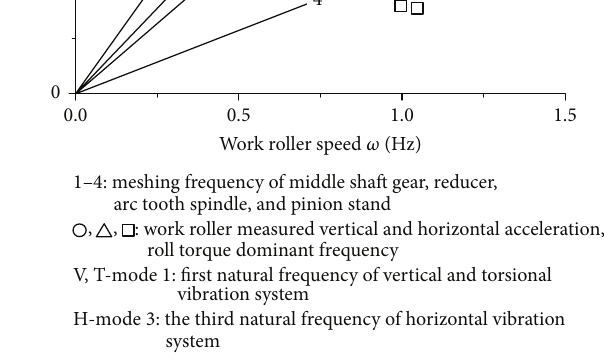
Figure 13: F 3 rolling mill speed map.